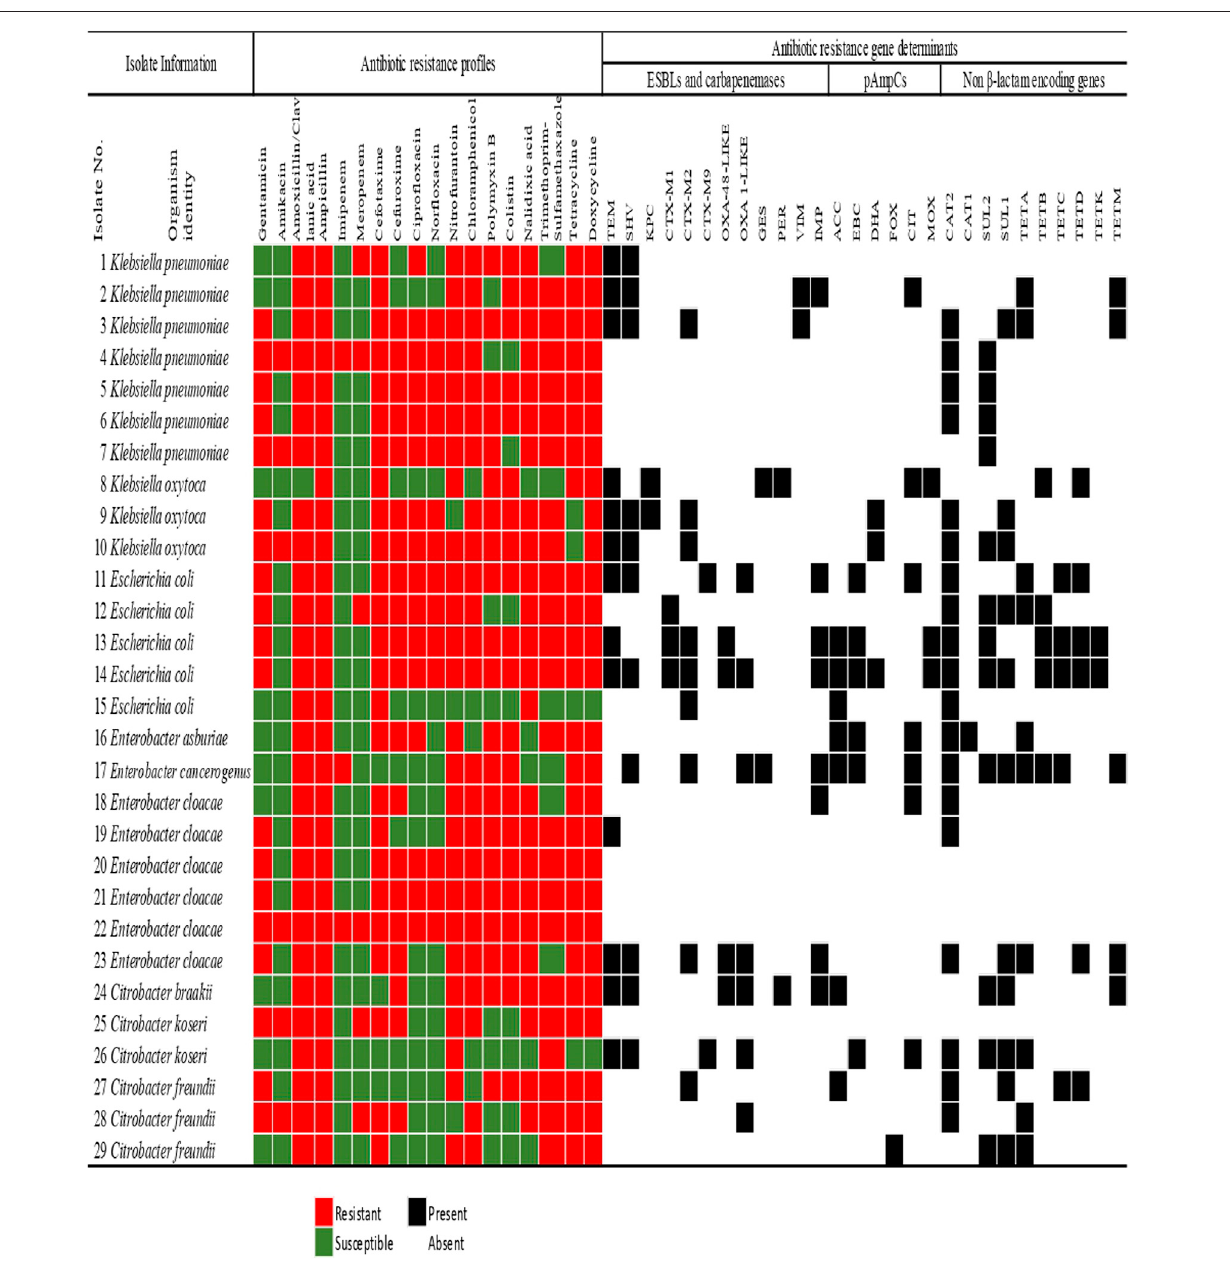
FIGURE3| TheAntimicrobialsusceptibilitypro fi lingofmembersoftheEnterobacteriaceaefamilyrecoveredfrommunicipalwastewatertreatmentplantsindicating the extended-spectrum β -lactamase and carbapenemases, plasmid-mediated AmpC β -lactamase, and non- β -lactam resistance determinants. The colour code of the antimicrobialsusceptibilitypro fi lesshowsthephenotypesoftheisolatestospeci fi cantibioticsin11differentclasses.Thedetectionoftheresistancegenedeterminantsis indicated as present or